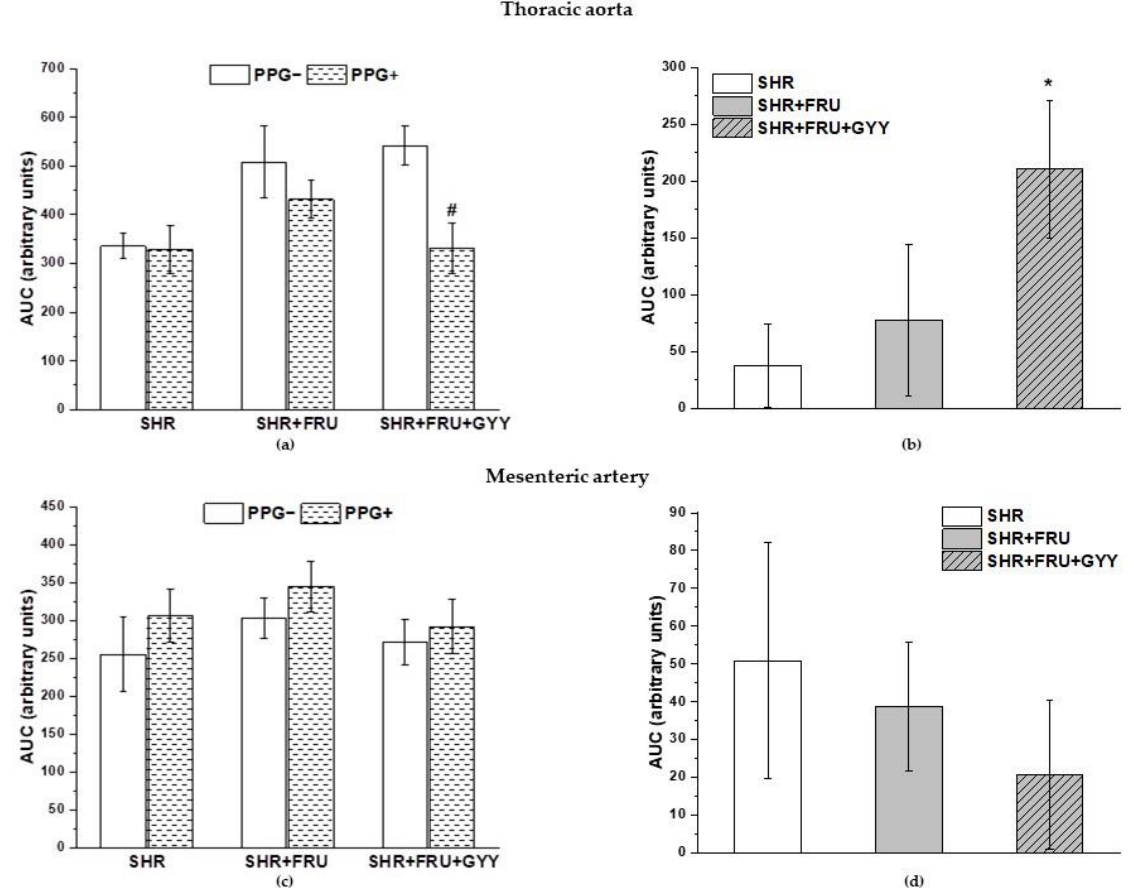
Figure 9. The participation of the H 2 S/CSE system in the relaxant responses of thoracic aorta ( a , b ) and mesenteric artery ( c , d ). The AUC calculated before and after the pre-treatment with PPG in individual groups ( a , c ). The difference between the AUC before and after PPG—comparison among groups ( b , d ). Arteries were isolated from spontaneously hypertensive rats (SHRs), SHRs treated with fructose (SHR+FRU), and SHRs treated with fructose and GYY-4137 (SHR+FRU+GYY). AUC—area under the curve; PPG—DL-propargylglycine. The data are presented as the mean ± S.E.M. Statistical analysis was performed by paired t -test or one-way ANOVA. * p < 0.05 vs. SHR, # p < 0.05 vs. PPG- within the relevant group.